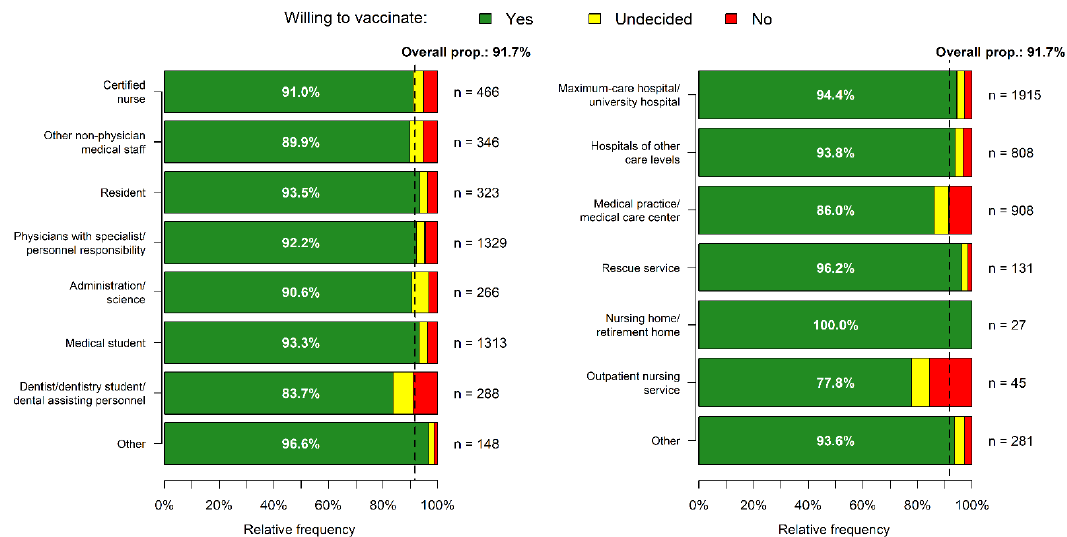
Figure 3. Vaccination acceptance in professional groups and work settings. The overall proportion of willing to be vac- cinated was 91.7%. Abbreviations: prop., proportion.